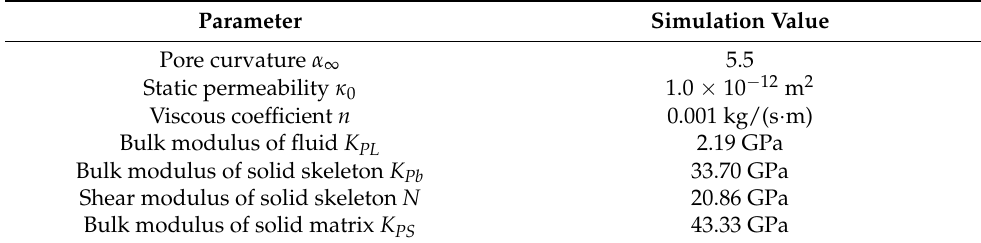
Table 2. Material properties of saturated porous medium at porosity β =